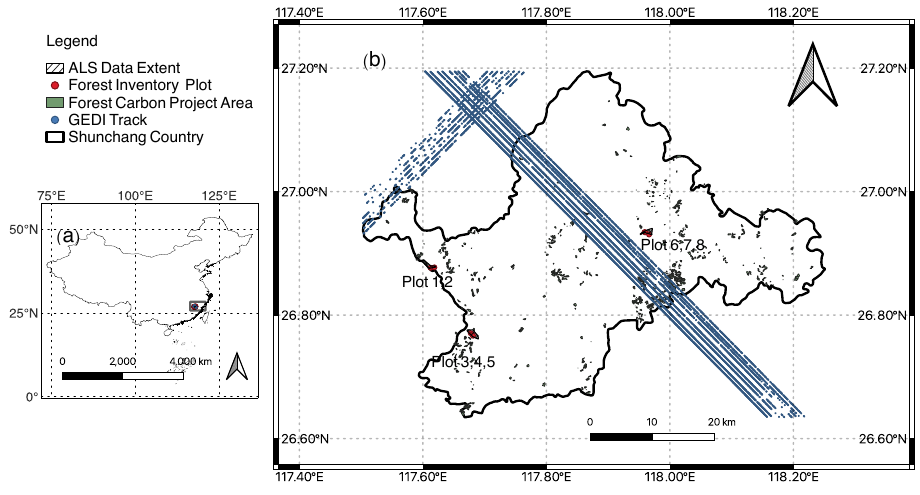
Figure 2. Map of the study area within ( a ) China. The main map ( b ) depicts two tracks of GEDI footprints (blue) used for dense canopy top height mapping and 909 discrete project area parcels scattered over Shunchang Country. The airborne LiDAR data extent is highlighted in red, in which each red circle represents one field